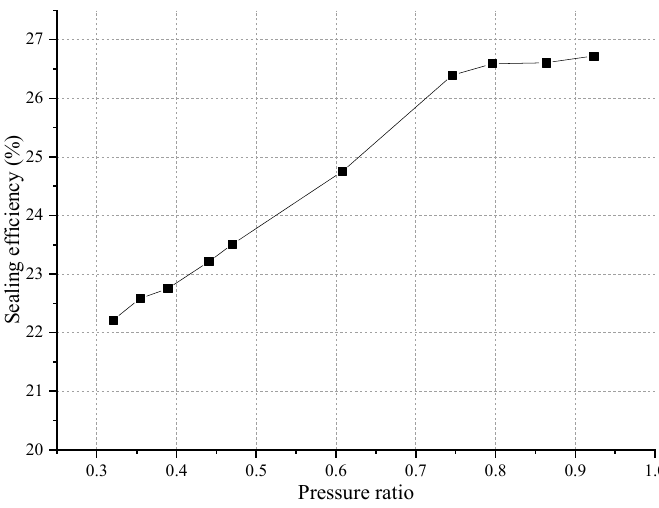
Figure 22. The e ff ect of pressure ratio on sealing e ffi Figure 22. The effect of pressure ratio on sealing efficiency.